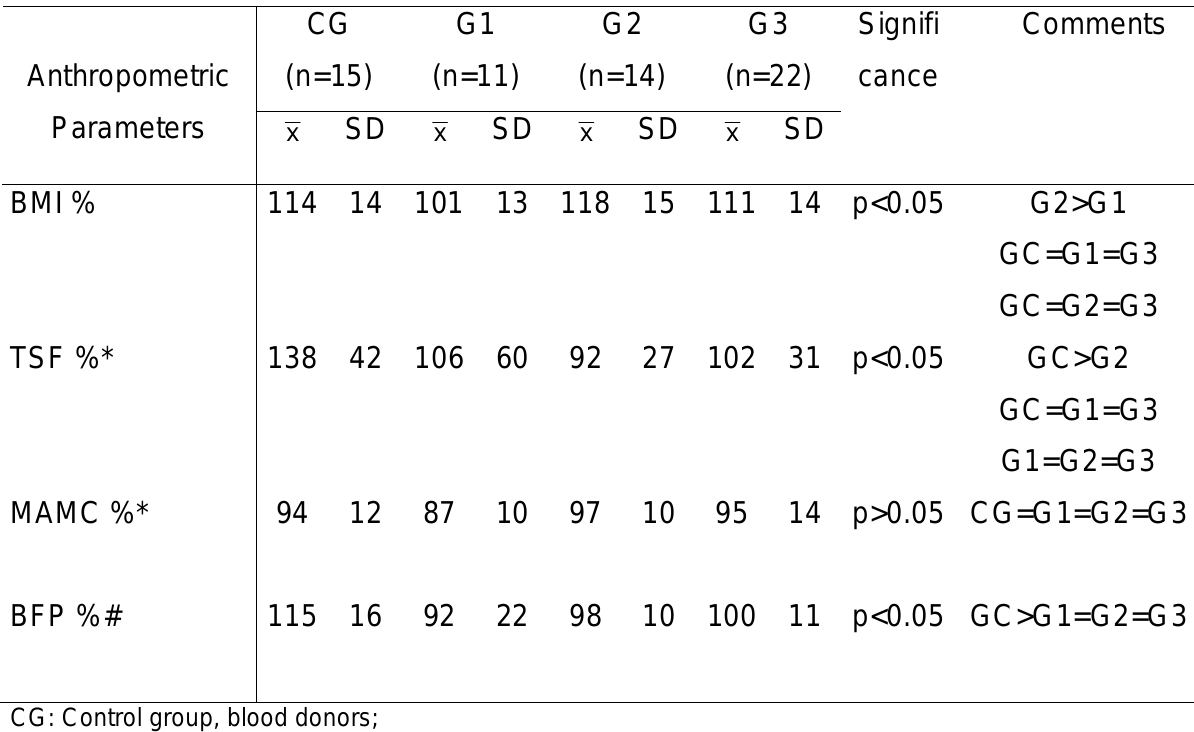
Table 4. Means ( x ) and standard deviation (SD) of percentage adequacy of anthropometric parameters of the 62 subjects, HIV-1 infected or not, according to the study